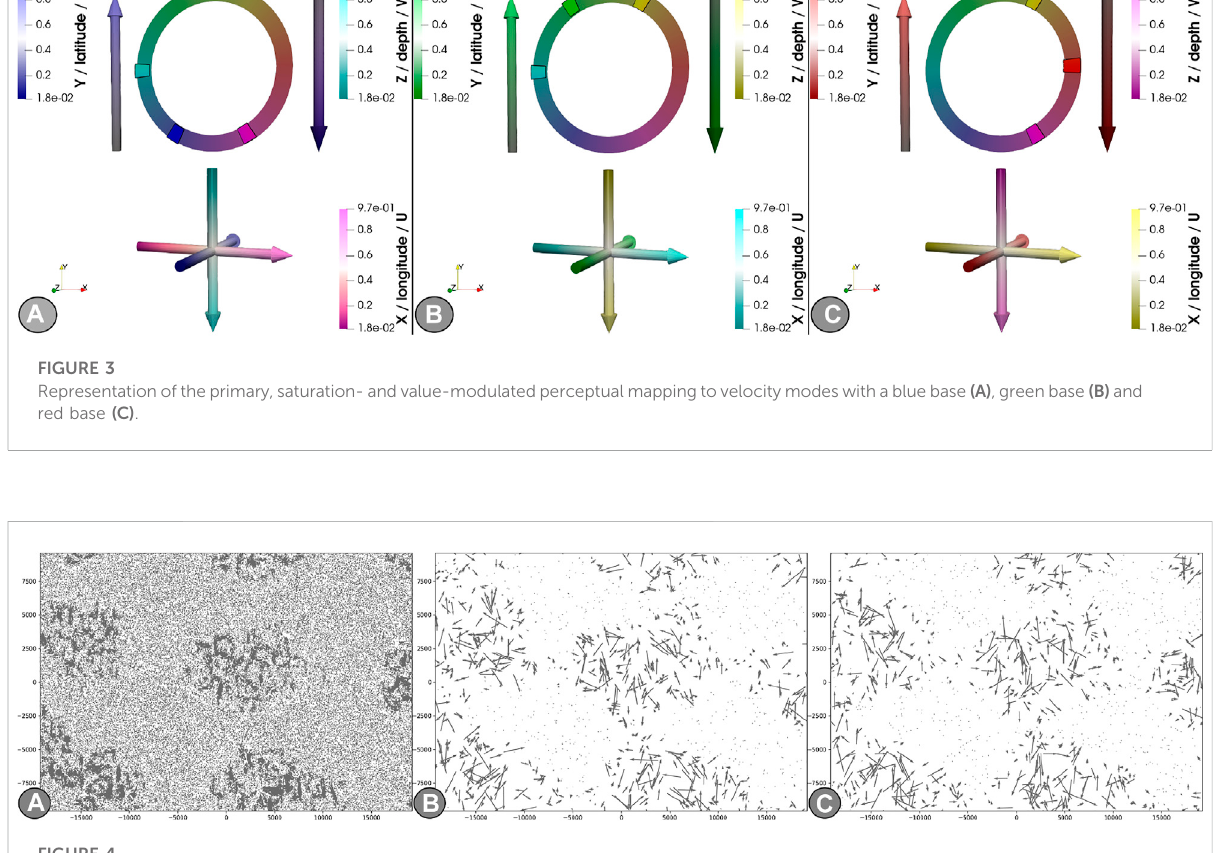
FIGURE 4 Frequent clutter hallucinator for hedgehog plots: representing zero-value data as points gives an illusion of information where none is present, by occupying the majority of the visual ink-space V . Sparser representations R ′ (A) reduce the clutter but do not alleviate it. Subsampled